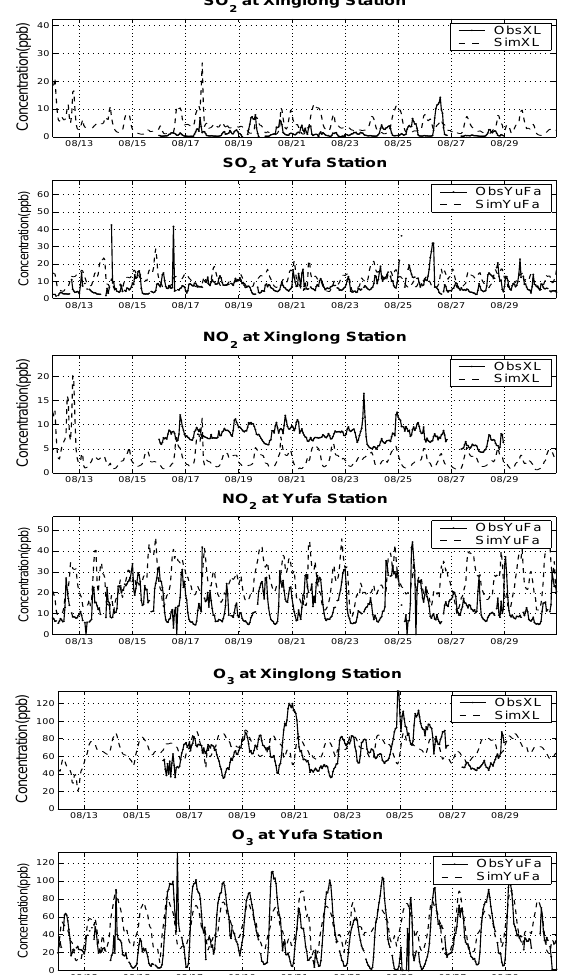
32 Fig. 4. Temporal variations of observed and simulated SO 2 , NO 2 Fig. 4. Temporal variations of observed and simulated SO 2 , NO 2 and Ozone (O 3 ) concentration at and Ozone (O 3 ) concentration at Xinglong and Yufa station in Au- gust Xinglong and Yufa station in August 2006.